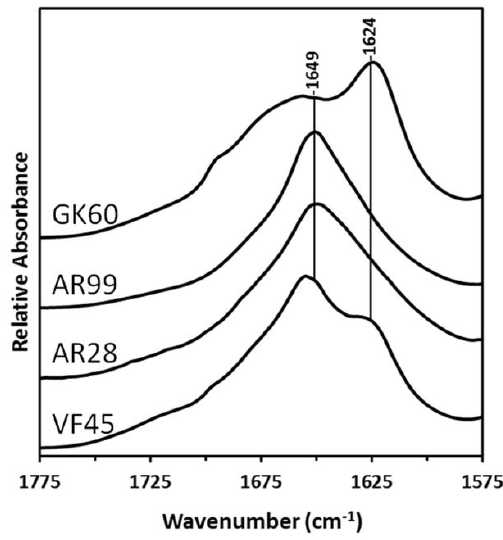
Figure 2. Amide I regions of the FTIR spectra obtained from cast films of the four peptides derived from different regions of the honeybee silk protein, as shown in Figure 1. The dominant coiled coil (1649 cm − 1 ) and β -sheet (1624 cm − 1 ) bands are indicated. Deconvolution peaks are shown in Supplementary Information Figure S2 and the proportion of each structure is shown in Table 1.